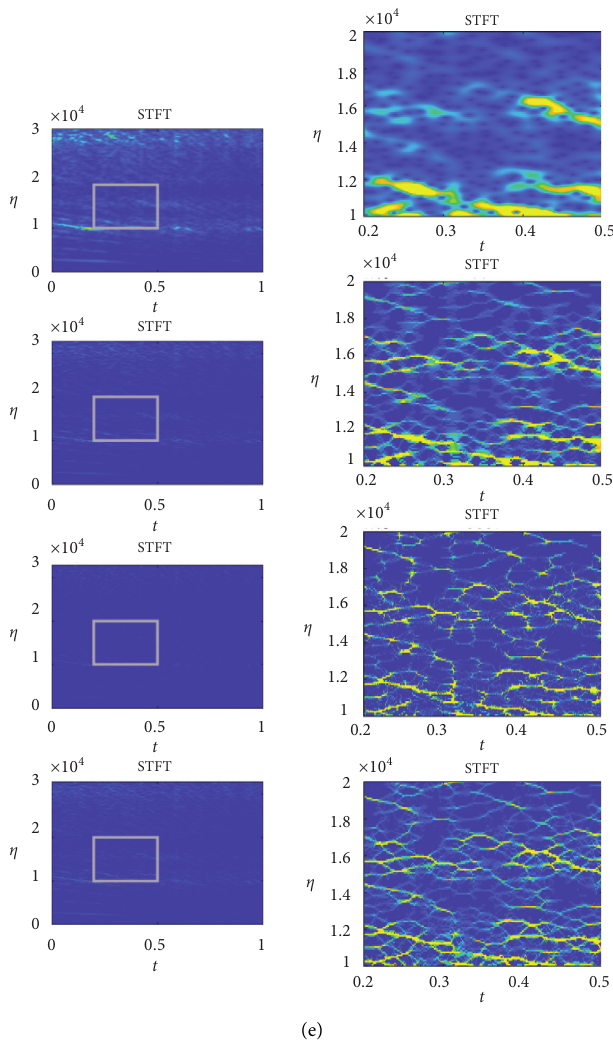
Figure 8: TFRs under different fault states: (a) fault-free, (b) ball fault, (c) inner race fault, (d) outer race fault, and (e) combined fault of inner and outer rings. Left column, from top to bottom: TFRs of STFT, SST, OSST, and VSST. Partial enlarged images of each representation are displayed in the right